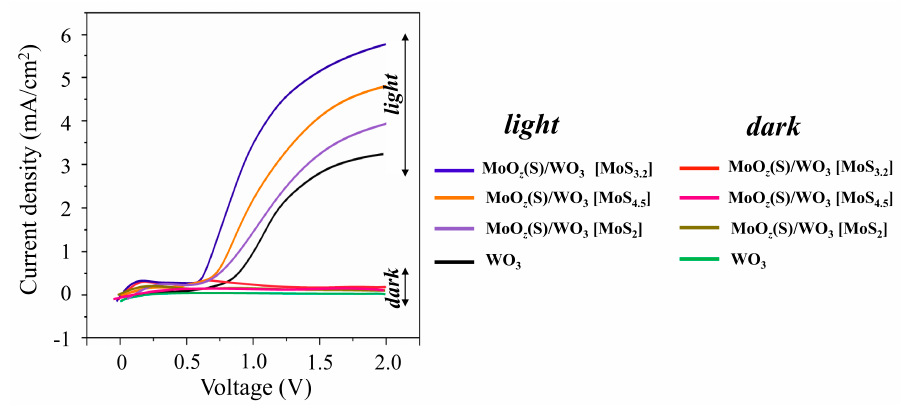
Figure 14. The LSV curves of WO 3 /FTO and different MoO z (S)/WO 3 /FTO samples measured in the dark and under illumination by a Xe lamp in 0.5 M H 2 SO 4. The MoO z (S) films were prepared by posttreatment of MoS x precursors with different content of S atoms (indicated in square brackets).